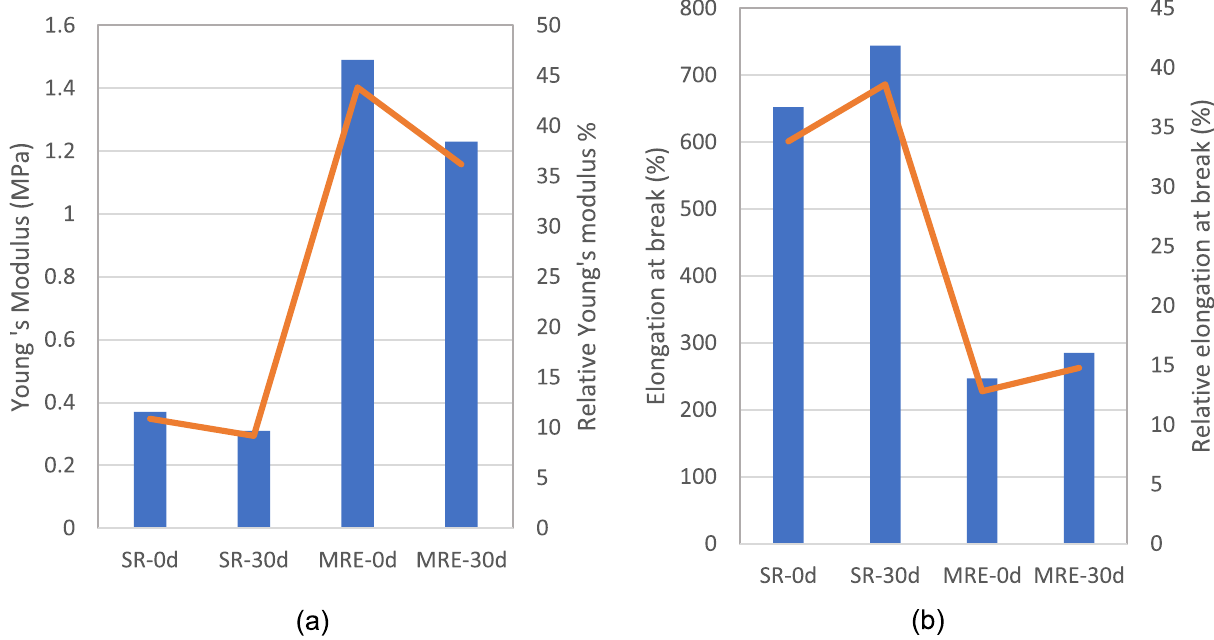
Figure 3. MRE and SR samples before and after immersion in the salt water ( a ) Young’s modulus and ( b ) elongation at